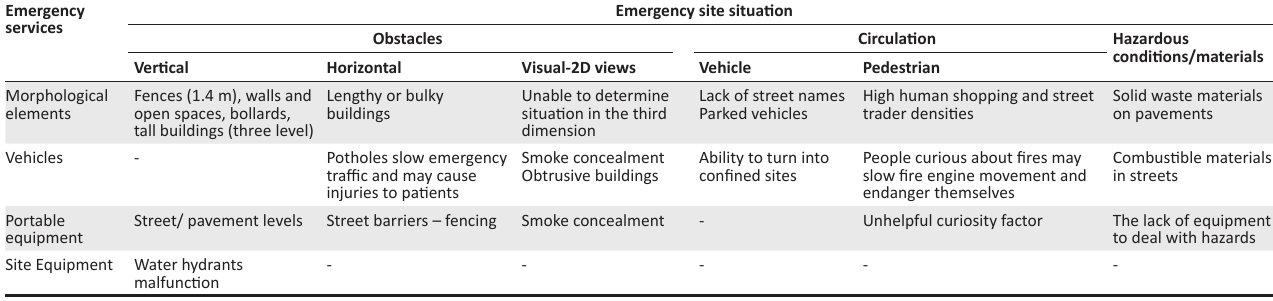
TABLE 4: Hazards generated from ‘worst case scenarios’ for the fire brigade. Emergency